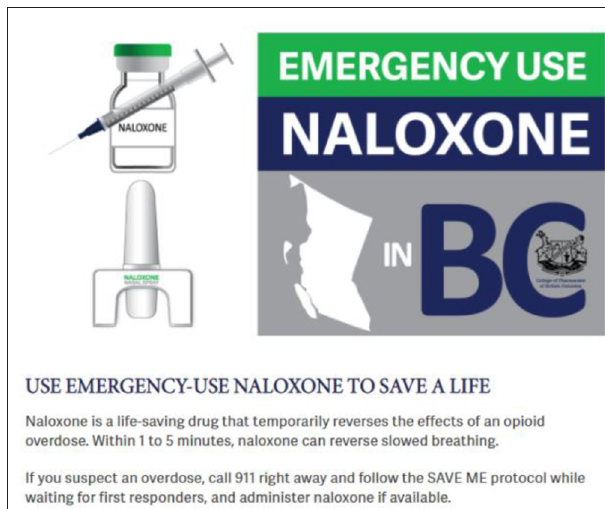
FIGURE 2 | British Columbia “Carry Naloxone” Campaign. Source: College of Pharmacists of British Columbia. 7